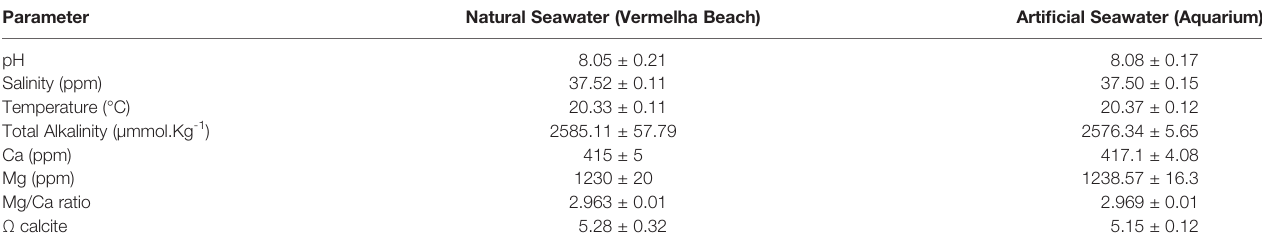
TABLE 1 | Natural and arti fi cial seawater quality parameters measured at Vermelha Beach (Natural seawater) and aquarium.